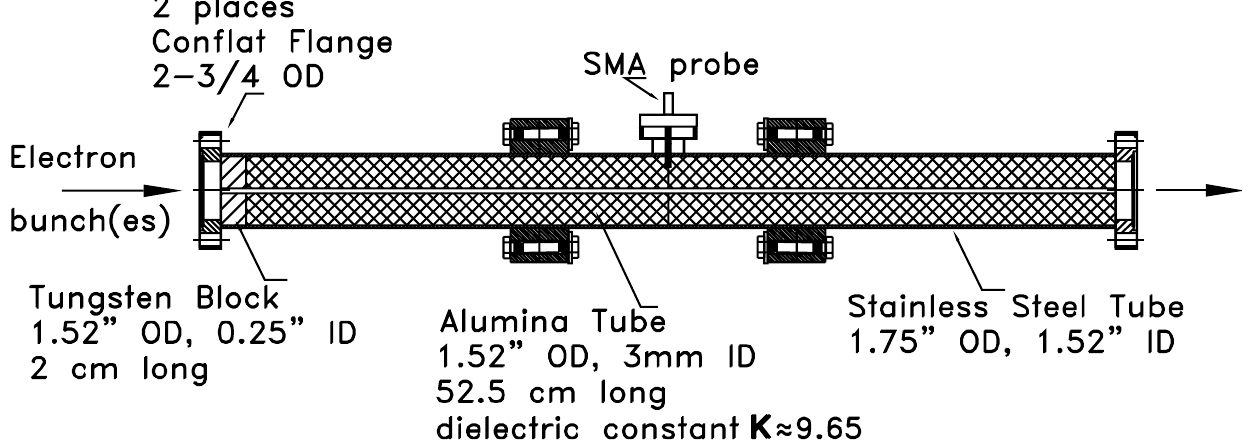
FIG. 1. Diagram of the dielectric-lined beam line element installed in the Omega-P/Yale/Columbia experiment at ATF, Brookhaven for studying wakefields.